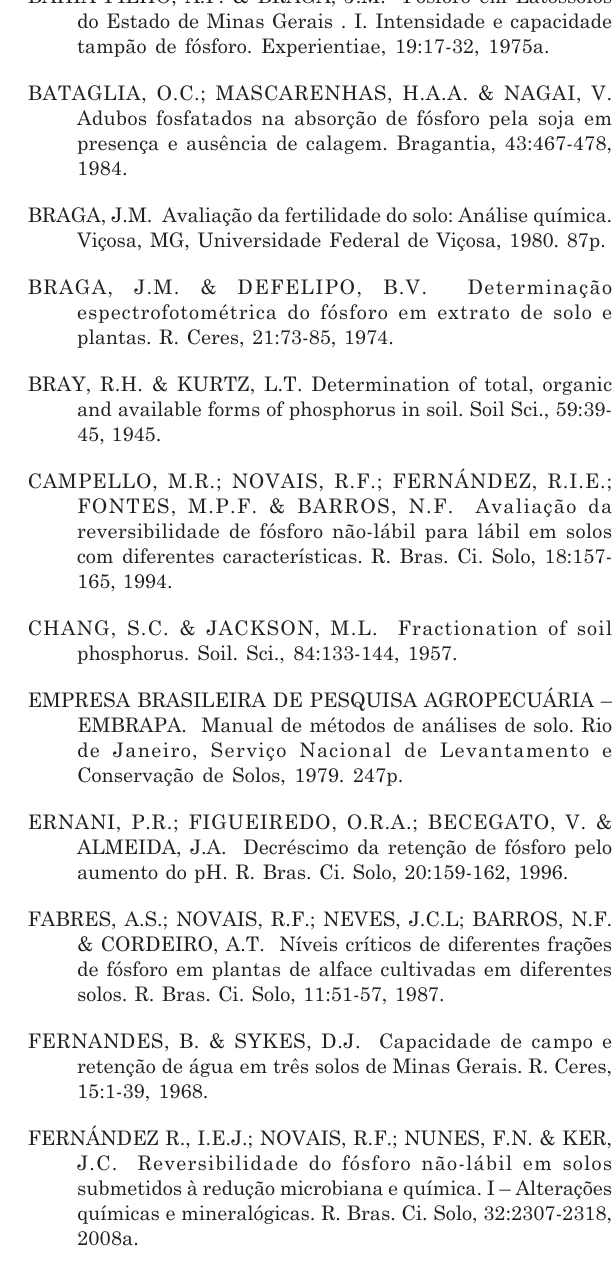
ns , * and **: non-significant and significant at 5 and 1 %,